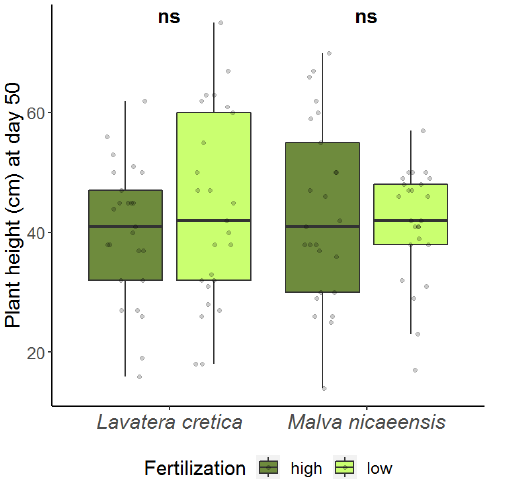
Figure 1. Development of L. cretica and M. nicaeensis in experimental open field (2019 – 2020). ( a ) Plant height 64 days and 121 days after sowing; ( b ) Leaf FW per plant 121 days after sowing. Each dot represents an individual plant; dots are distributed horizontally for visual clarity. *** and **** indicates p -value ≤ 0.001 and p -value ≤ 0.0001, respectively.